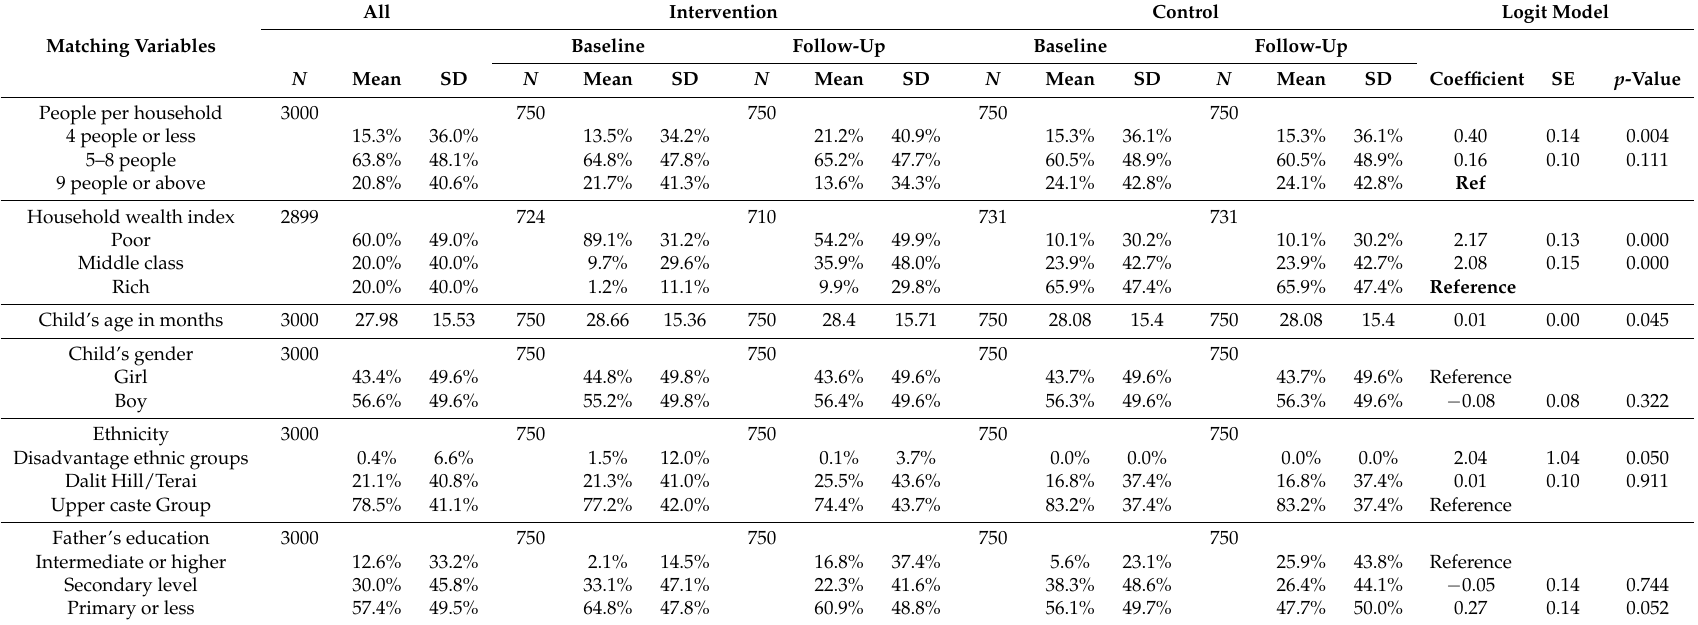
Table 2. Summary statistics of the matching variables and estimates of logit regression models for stage 1 of propensity score